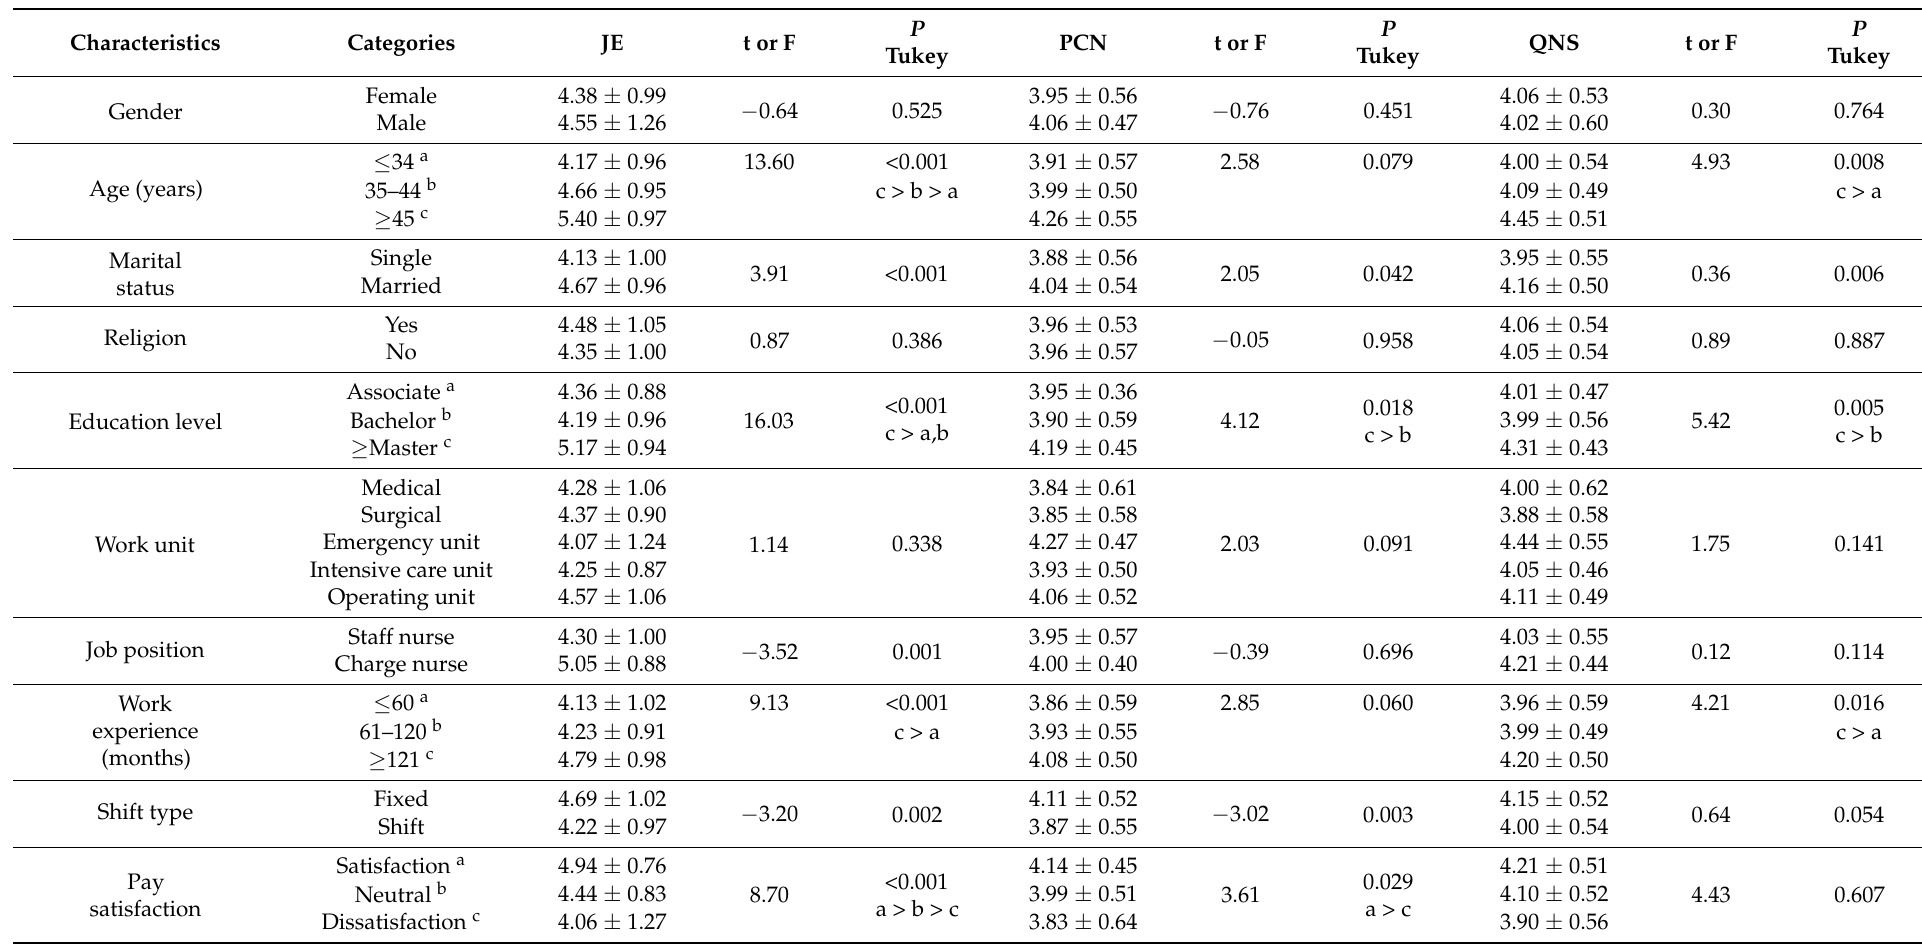
Table 2. Differences in job engagement, person-centered nursing, and quality of nursing services according to general characteristics of participants ( N =